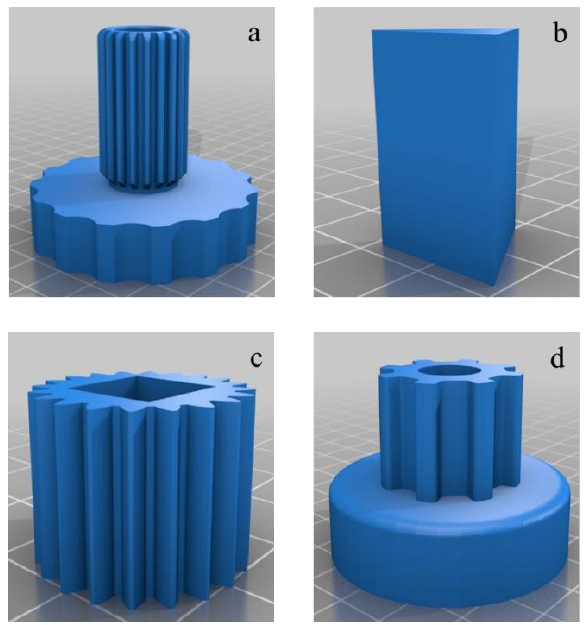
Figure 7. Rendering of STereoLithography (STL) models for testing: ( a ) sun gear; ( b ) prism; ( c ) gear; and ( d ) t55gear.